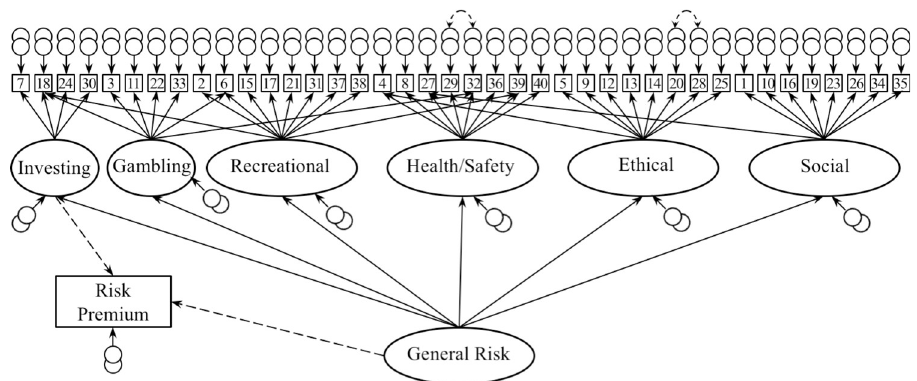
Fig 1. Diagram of model tested. Measurement model based on forty observed responses to the risk-behavior scale of the DOSPERT includes six domain-specific factors and one domain-general factor. Dashed lines indicate paths added for structural model testing on independent measures of risky choice behavior. Following standard practice, rectangles represent observed data and ovals represent latent variables.